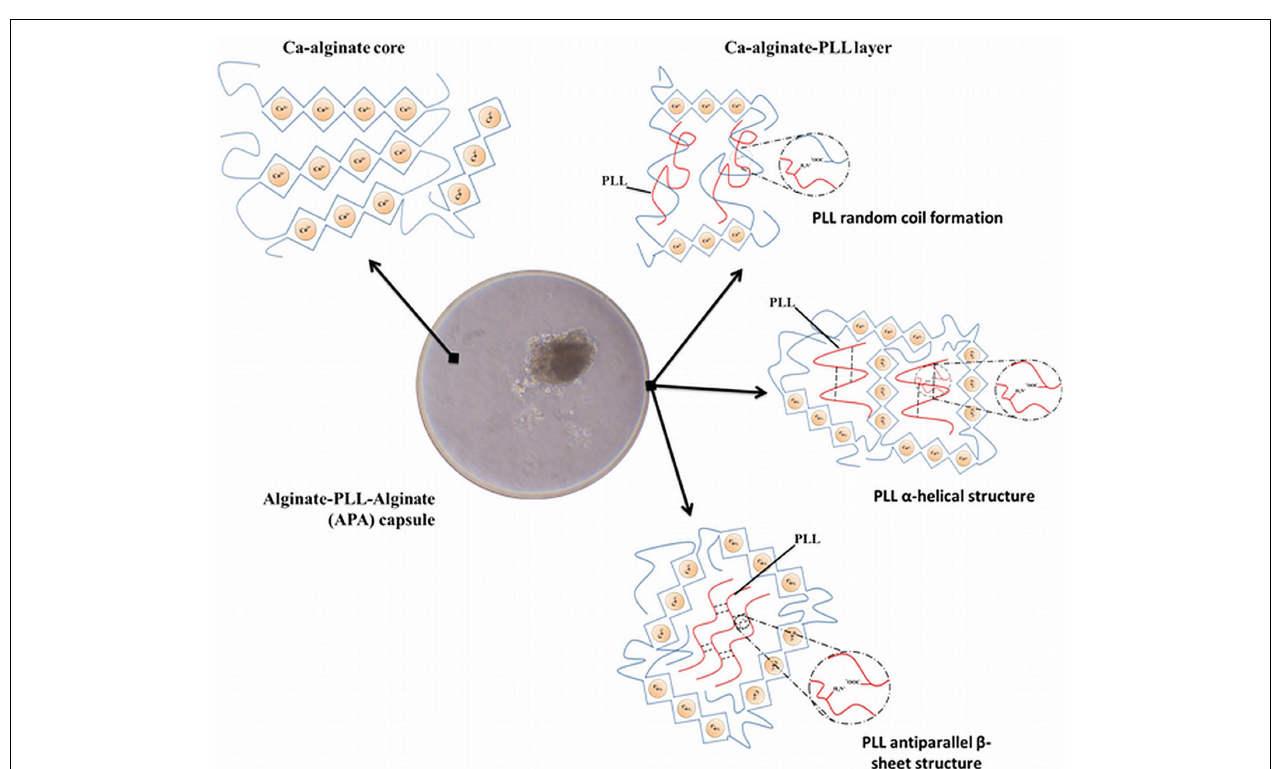
be substituted by poly- L -lysine (PLL) to form a complex alginate-PLL- alginate (APA).The PLL-alginate layer can take three different structures by intramolecular hydrogen binding, (i) random coil formation between alginate and PLL, (ii) α -helicoidal structure between amide groups of PLL, and (iii) antiparallel β -sheet structure between amide groups of